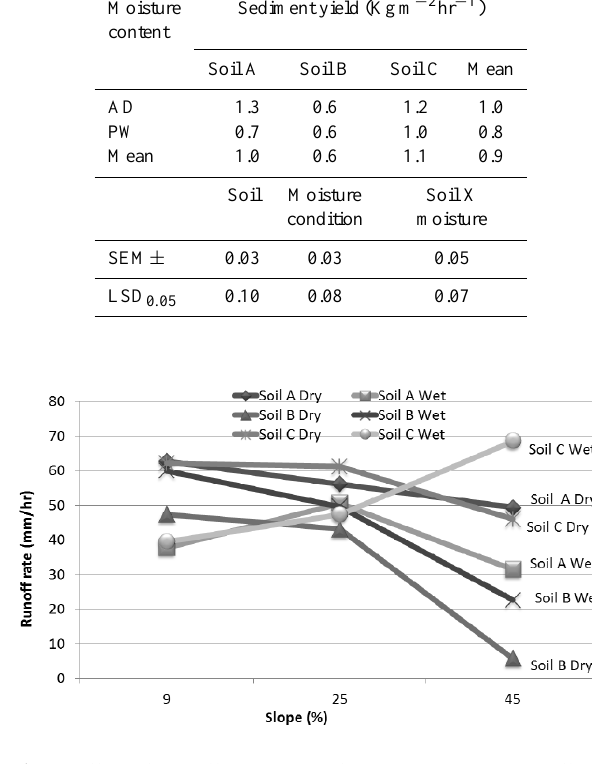
Fig. 1. Effect of the different levels of slope steepness on runoff rate Figure 1 Effect of the different levels of slope steepness on runoff rate for the three soils at two for the three soils at two levels of initial moisture levels of initial moisture content